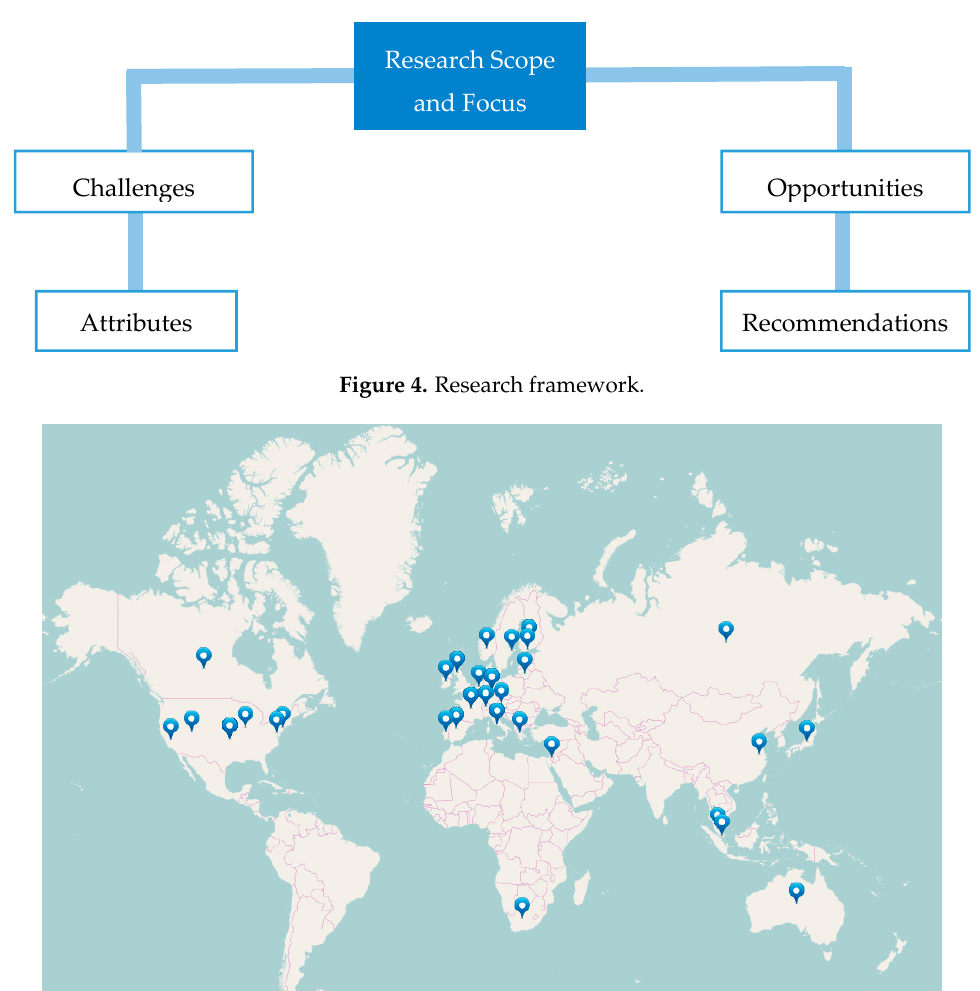
Figure 5. Distribution of literature all around the world.